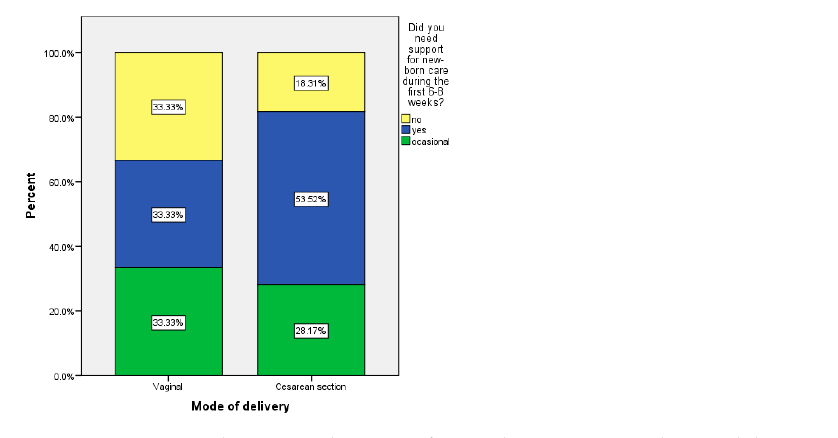
Figure 3. Patients who required support for newborn care according to delivery mode.